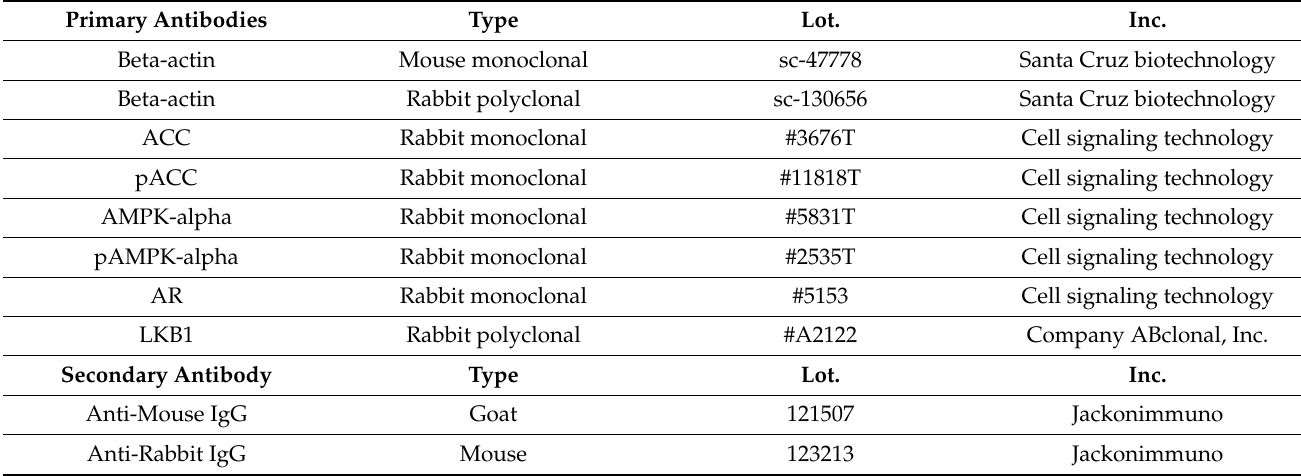
Table 1. Antibodies used for Western Blotting and Chromatin Immunoprecipitation Assay. Primary